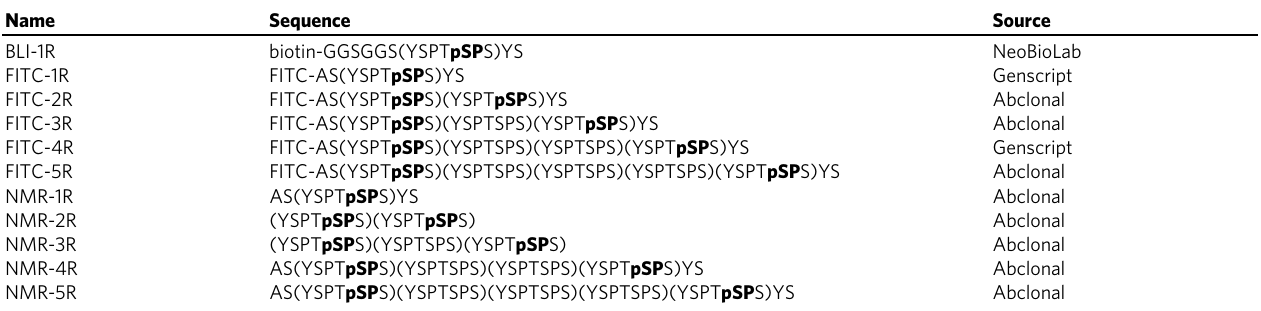
Table 2 Peptides used in this study.